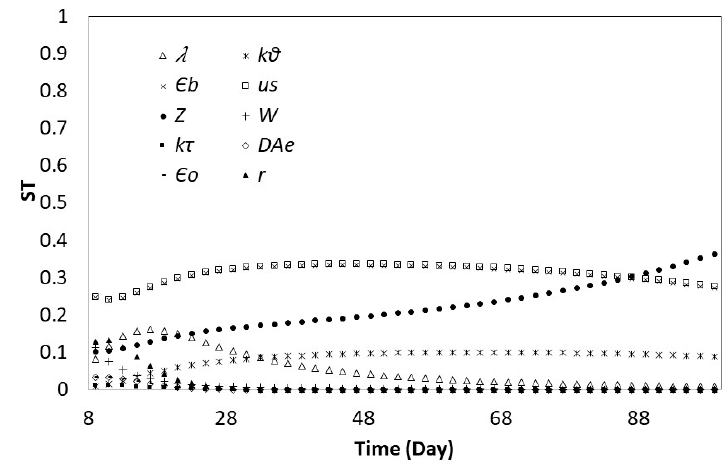
Figure 12. GSA of the model at D Ae 0.112 cm 3 /cm 2 · d.